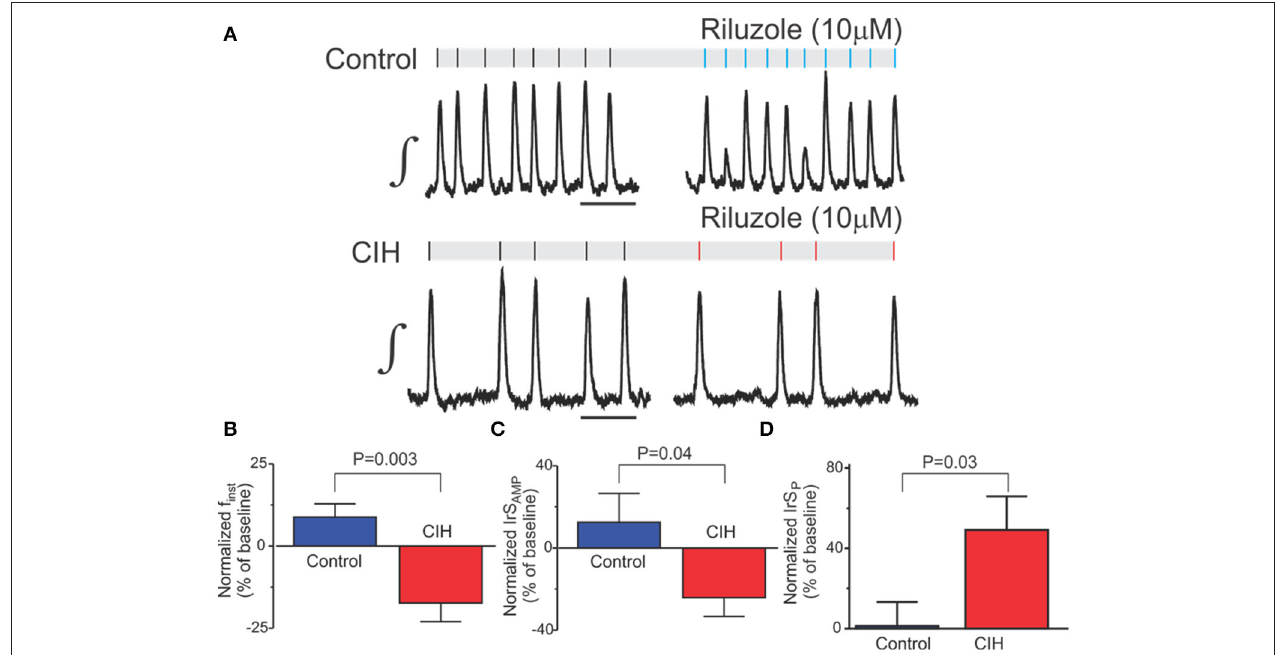
FIGURE 5 | CIH changes riluzole sensitivity of rhythmogenesis. (A) Representative examples of integrated traces of the preBötC rhythm from control (top) and CIH (bottom) before and during exposure to riluzole. Scale Bar: 5 s (B–D) CIH affects the change in finst, IrS AMP , and IrS P in